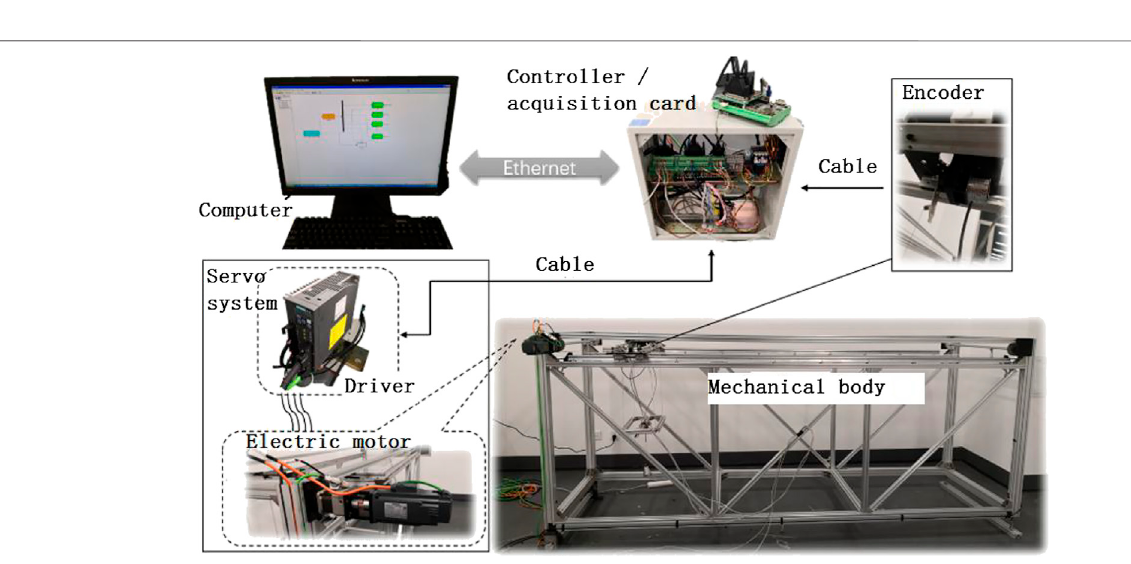
FIGURE 6 | Experimental physical